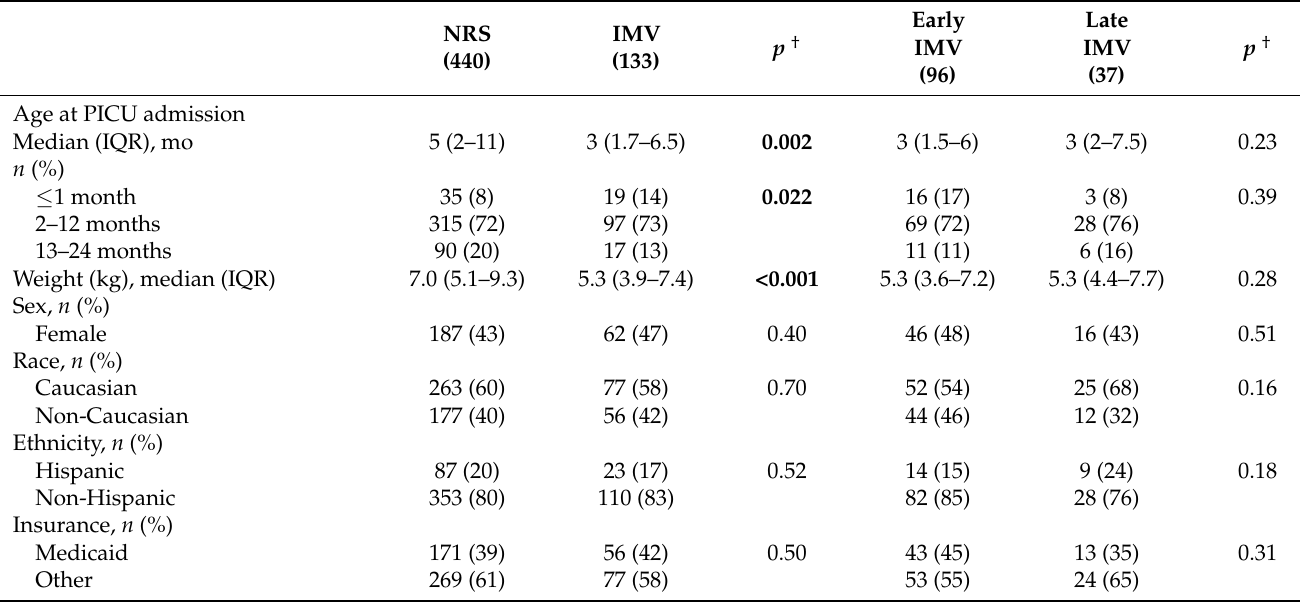
Table 1. Patient Demographics (all groups, n =